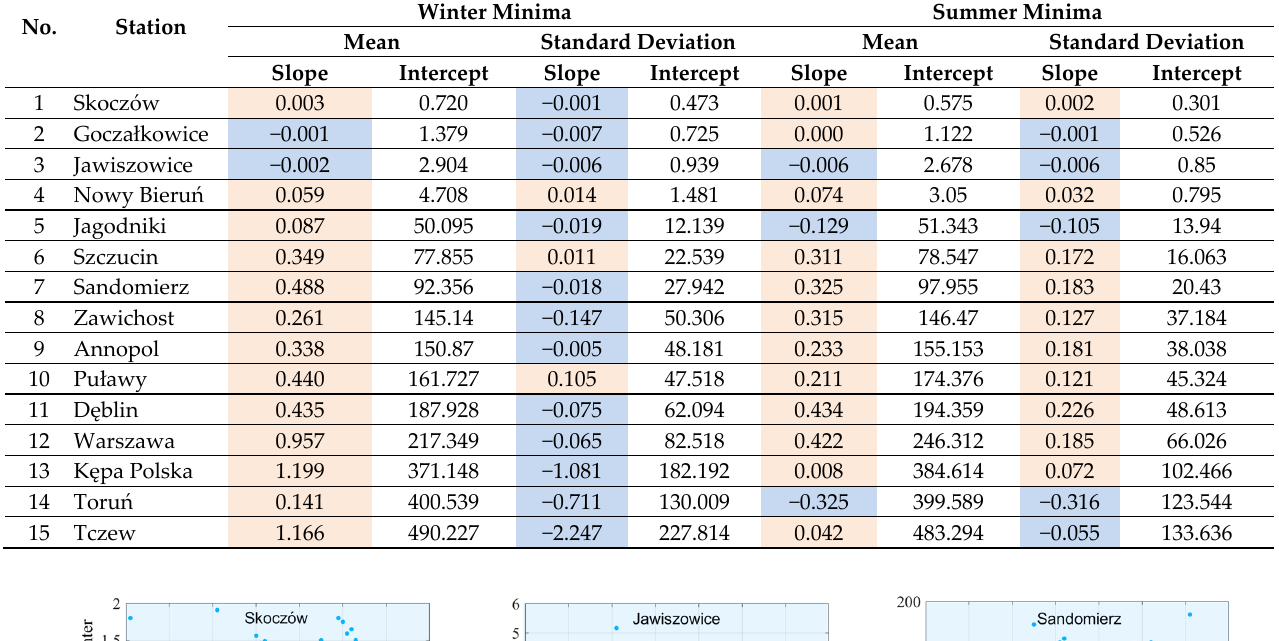
Table 12. Parameters of linear trends in the mean value and standard deviation of instantaneous seasonal minimal flows at the stations on the River Vistula; orange colour denotes positive trend, blue colour negative.